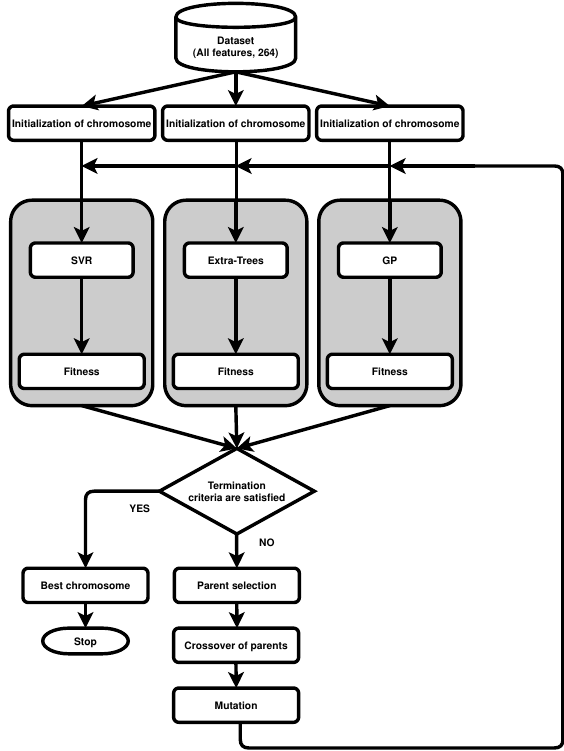
Figure 3. Flowchart of our genetic